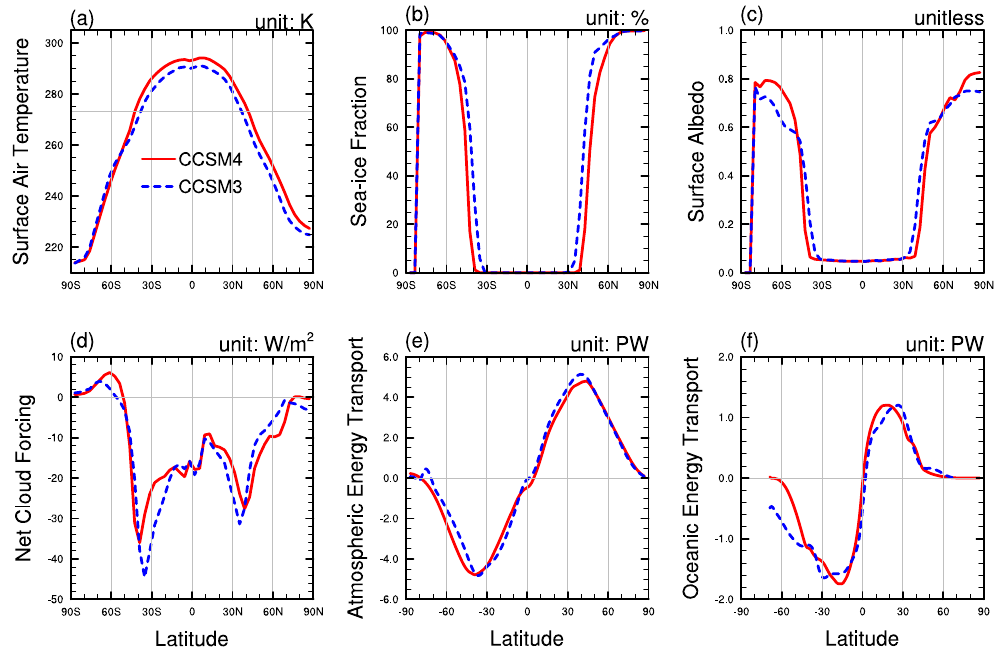
Fig. 2. Same as Fig. 1, but for the experiment with 94% solar radiation and 286ppmv CO 2